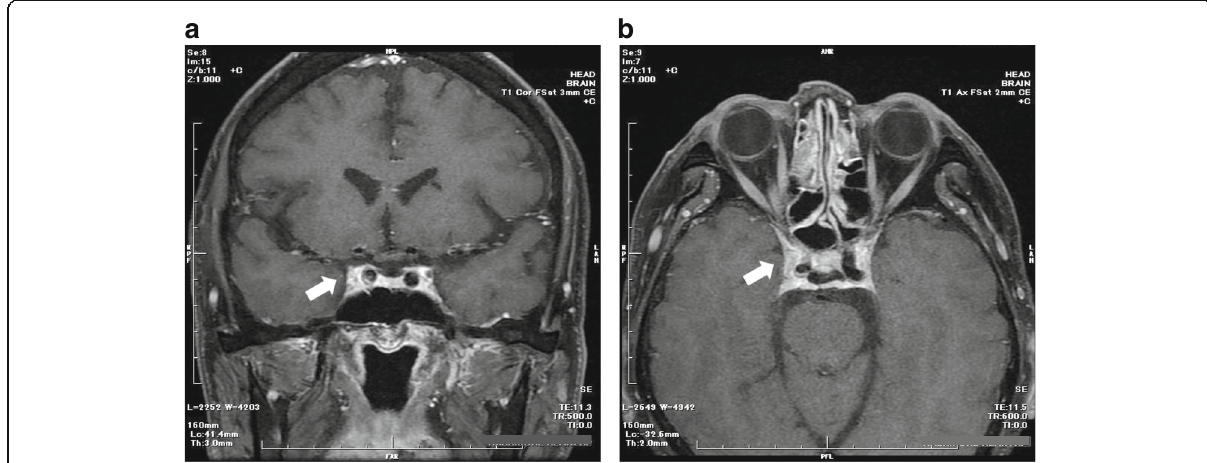
Fig. 2 a Coronal T1 scan of brain MRI with gadolinium. b Axial T1 scan of orbital MRI with gadolinium. Both images show the lesion expanding from the right cavernous sinus to the orbital apex